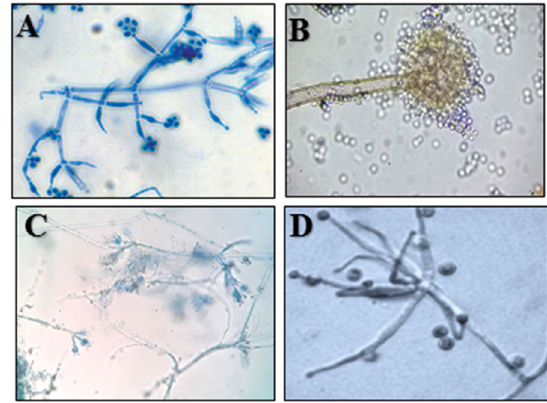
Fig. 1 Microscopic photographs of A Trichoderma harzianum B Aspergillus niger C Penicillium chrysogenum D Pochonia chlamydosporium